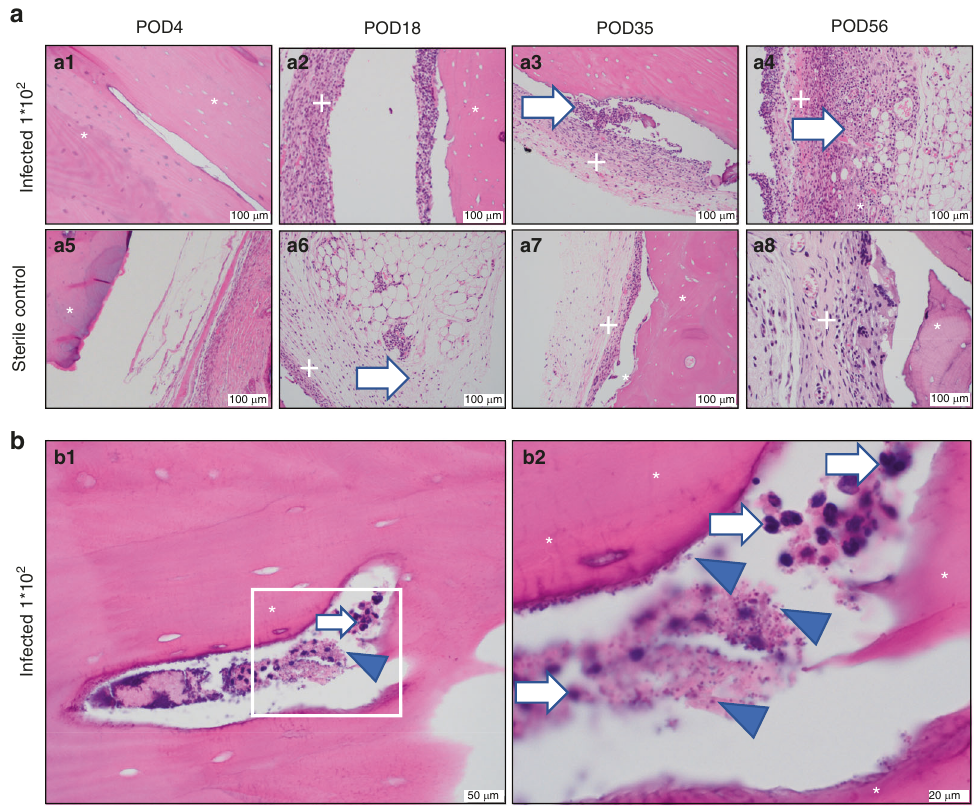
Fig. 3 Cortical allograft histology. a All images taken at ×200. Hematoxylin and eosin stain. a1 – a4 Inoculated with 1 × 10 2 CFU S. aureus . a5 – a8 Sterile control. a1 POD 4, acute in fl ammatory cells, no capsule; a2 POD 18, thick in fl ammatory capsule and evidence of neovascularization in cortical bone; a3 POD 35, thick in fl ammatory capsule and evidence of neovascularization in cortical bone; a4 POD 56, neovascular formation within thick capsule and extensive in fl ammatory reaction, a5 sterile POD 4, acute in fl ammatory cells, no capsule; a6 sterile POD 18; a7 sterile POD 35, thin in fl ammatory capsule, no evidence of bacteria, and a multinucleated giant cell with resorption pit; a8 sterile POD 56, thin in fl ammatory capsule, no evidence of bacteria. Note in particular the increased cellularity and in fl ammatory presence in the infected specimens compared to the sterile specimens. * = bone, + = capsule, white arrow = in fl ammatory cells, blue arrowhead = cocci bacteria. b Hematoxylin and eosin stain. Inoculated with 1 × 10 2 CFU S. aureus . b1 ×400, bacterial cocci within haversian canal. b2 POD 56, ×1 000, inset. Bacterial cocci and in fl ammatory cells within haversian canal. Note in particular the presence of both cocci bacteria and in fl ammatory cells co-existing in the same haversian canal space. * = bone. White arrow = in fl ammatory cells. Blue arrowhead = cocci infected specimens compared to sterile, but there was no evidence of bacteria (Fig. 4 and Supplementary Fig. 11). Live/dead confocal microscopy Fluorescent confocal microscopy revealed extensive green- fl uorescent (live) and red- fl uorescent (dead) bacteria on the infected cortical allograft specimens at 1 × 10 2 inoculum. Live stain only images demonstrate the presence of live bacteria with background red- fl uorescence subtracted. Sterile specimens, and infected 1 × 10 2 stainless steel discs, revealed few live bacteria and some dead bacteria (Fig. 5). Infected and sterile cancellous allograft specimens revealed extensive green and red- fl uorescent staining in both specimens (Fig. 5).